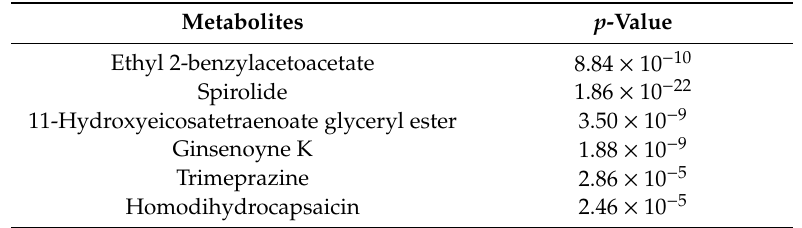
Table 3. List of Most Upregulated Metabolites in HTFs-Treated Group. From the upregulated list, six metabolites were identified as the most upregulated metabolites in ranibizumab-treated-HTFs.